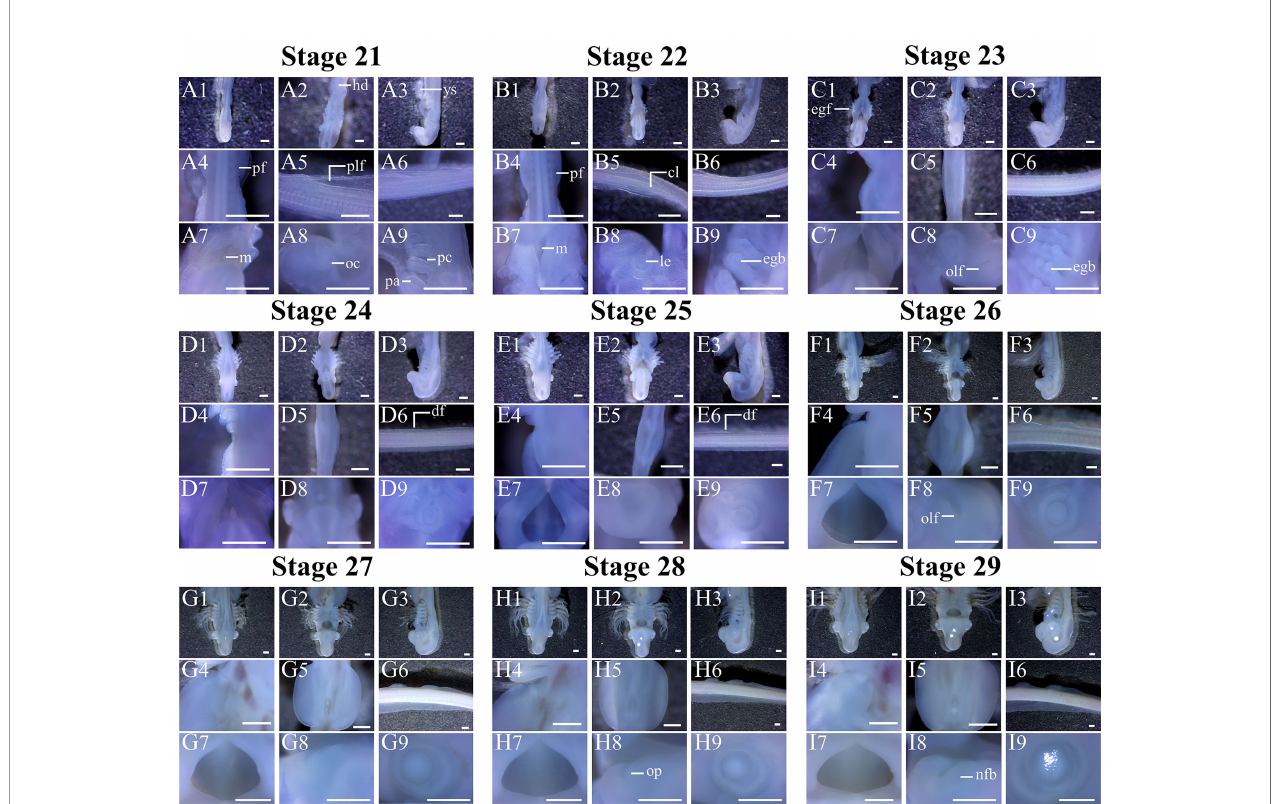
FIGURE 4 | Key characteristics of O. kenojei embryos in developmental stages 21 – 29. Bar = 0.05 cm. The pictures of each stage labeled with 1, 2, and 3 indicate the changes in the embryo ’ s head. The pictures labeled with 4, 5, 6, 7, 8, and 9 show the development of the embryo ’ s pectoral fi n, pelvic fi n, dorsal fi n, mouth, nose, and eye, respectively. cl, cloaca; df, dorsal fi n; egb, external gill buds; hd, heart disc; le, lens; m, mouth; nfb, nasal fl ap buds; oc, optic cup; olf, olfactory placode; op, olfactory pits; pf, pectoral fi n; plf, pelvic fi n; op, olfactory pits; ys, yolk